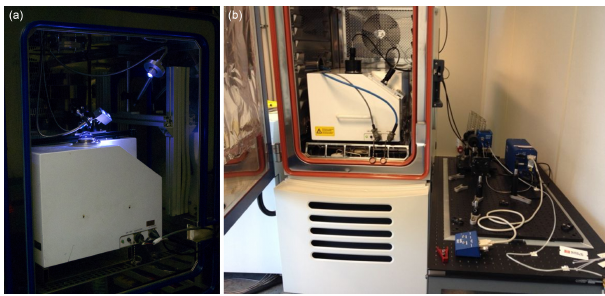
Figure 4. Pictures showing Brewer instruments in the controlled environment chambers for the measurements at the PTB (a) and at the Kipp & Zonen facilities (b)